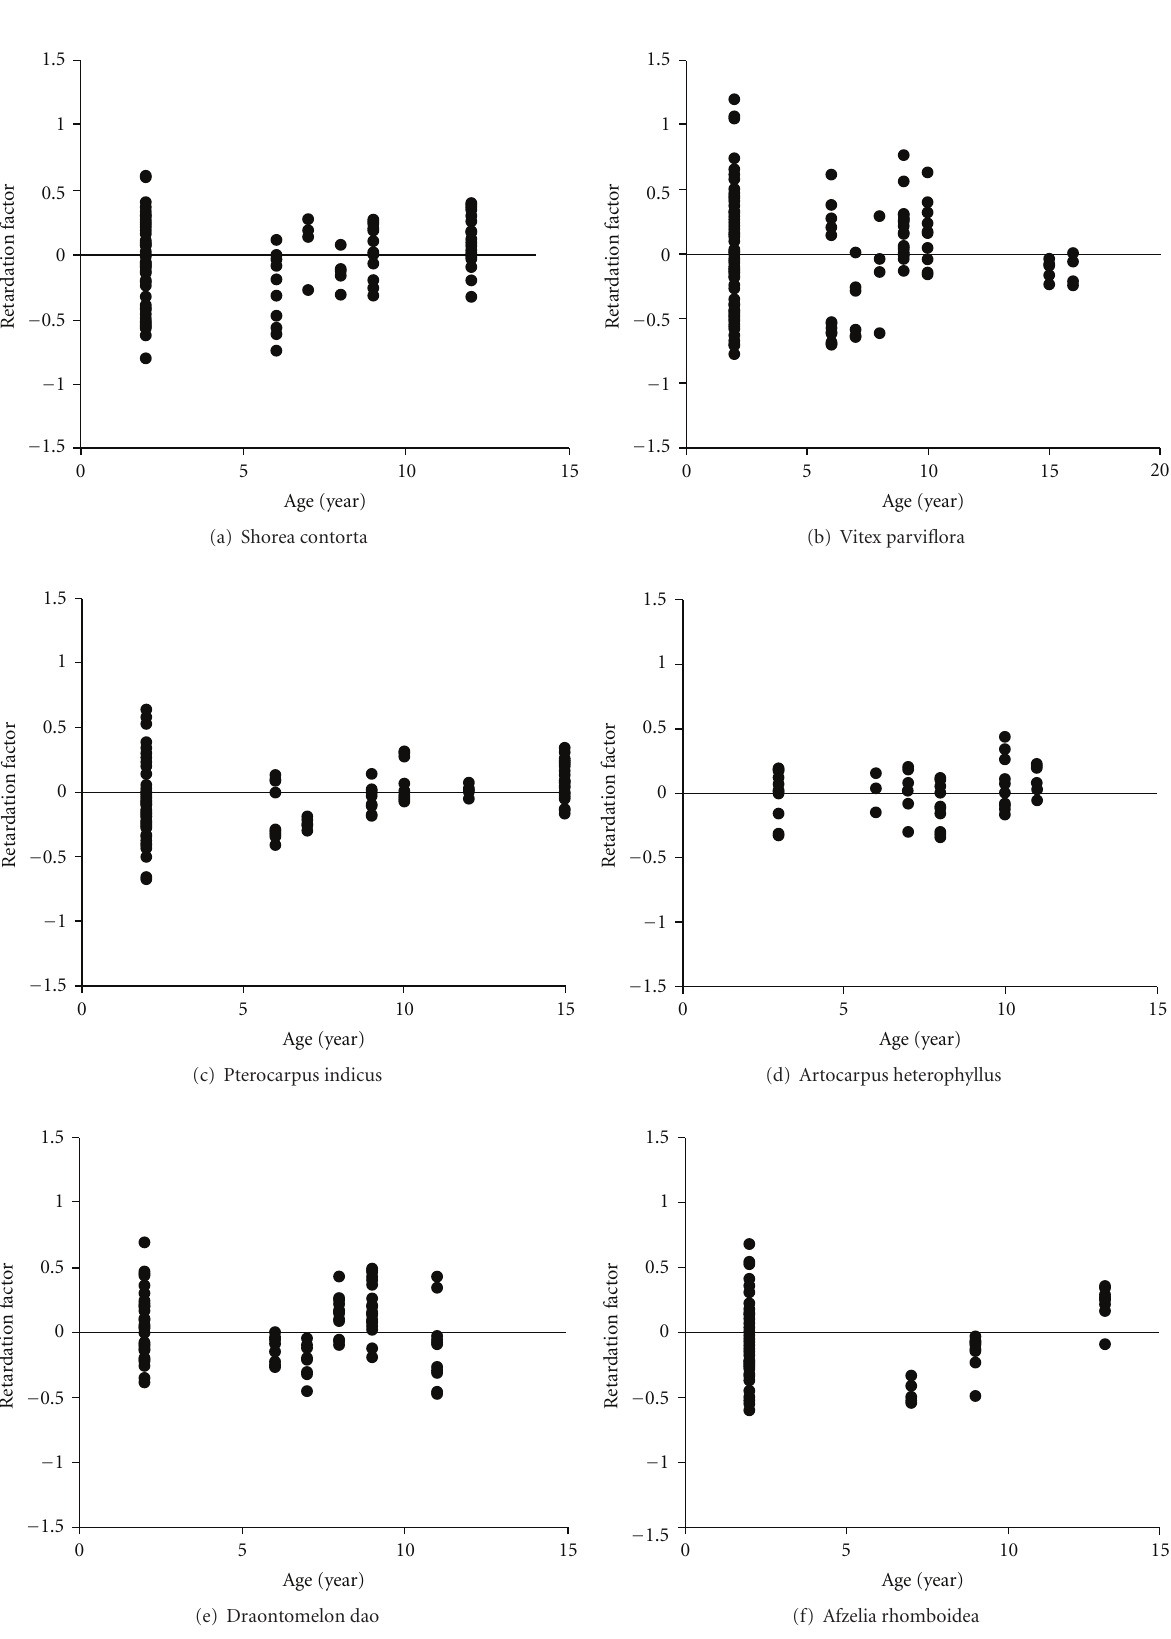
Figure 3: Growth Retardation Factor for six native tree